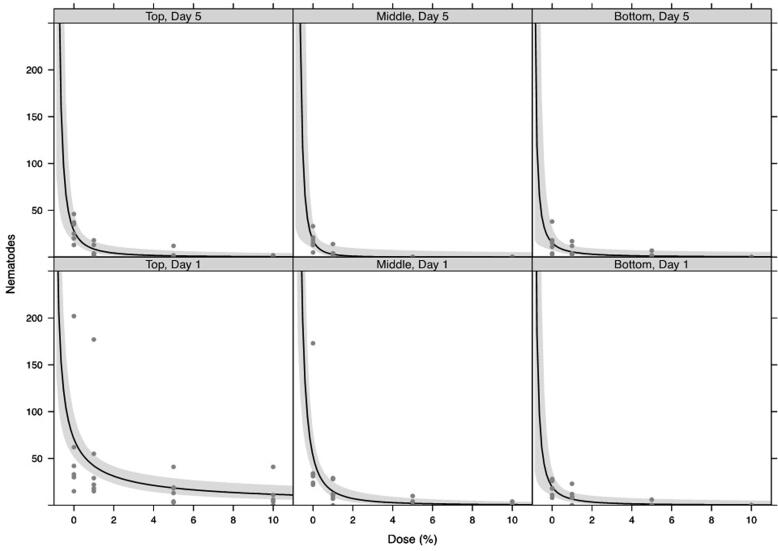
Dose-response curves for numbers of M. hapla retrieved following treatment with VOC 1-octen-3-ol. Nematodes were recovered from ‘Top’, ‘Middle’, and ‘Bottom’ sections of experimental tubes, after both 1 and 5 days post treatment. Fitted lines show log-linear responses. Shaded ribbons show 95% confidence envelopes.